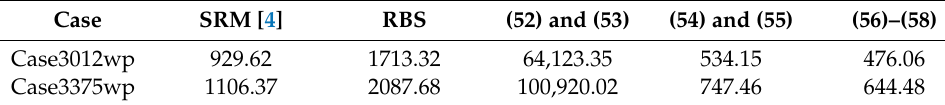
Table 12. Solution times (ms) for ill-conditioned cases with reactive